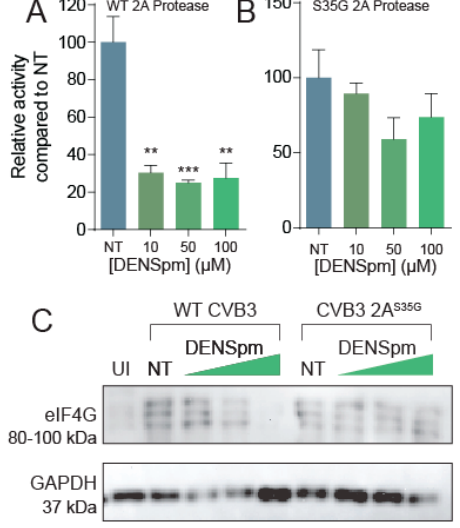
Figure 5. DENSpm reduces 2A protease activity. Split luciferase protease activity reporter systems were cloned and co-transfected with ( A ) wildtype 2A or ( B ) 2A S35G mutant into Vero cells left untreated or treated with increasing doses of DENSpm. Firefly luciferase activity was measured 24 h later and normalized to renilla luciferase transfection efficiency control and subsequently normalized to untreated cell transfection. ( C ) Vero cells were left untreated or treated with increasing doses of DENSpm for 16 h prior to infection with wildtype CVB3. Total cellular protein was collected 24 hpi and analyzed via Western blot for eIF4G and β -actin. ** p ≤ 0.01, *** p ≤ 0.001 using Student’s t -test ( n = 2), comparing treated samples to untreated controls. Error bars represent ± 1 SEM.